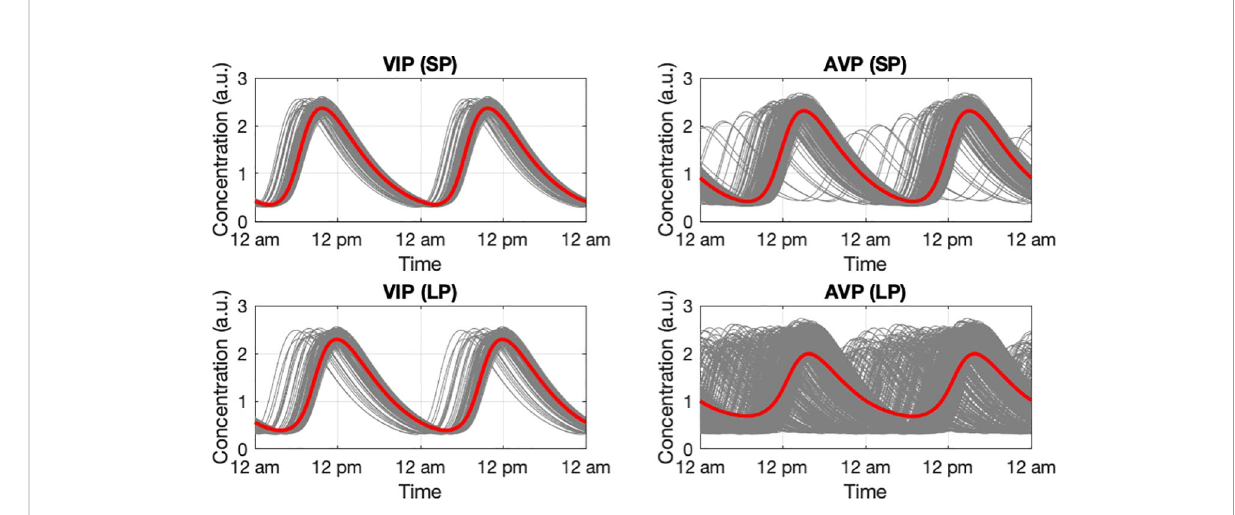
FIGURE 8 Circadian dynamic of the core and shell under short photoperiod and long photoperiod. VIP and AVP circadian pro fi les were plotted as they are the representative components in the core and the shell. During SP, both the core and the shell have a narrower phase distribution compared to LP. The higher synchronization level results in an increase in the ensemble average amplitude. The simulation was conducted with 200 cells in the core and 600 cells in the shell.